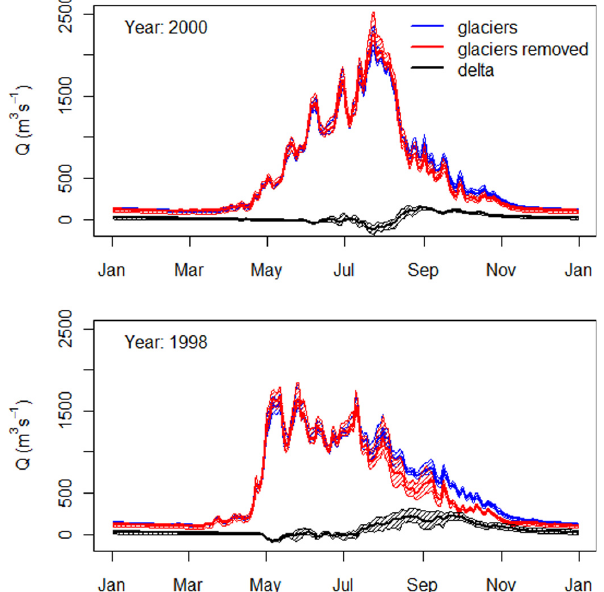
Fig. 9. The effect of glaciers on discharge shown by comparing simulations with and without glaciers for the year with the high- est modelled ice melt (1998) and the year with the lowest ice melt